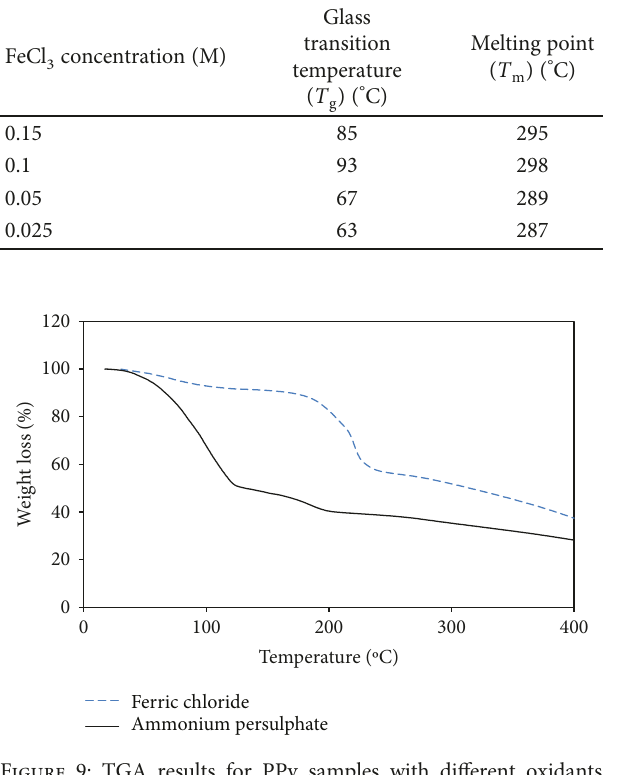
Figure 9: TGA results for PPy samples with di ff erent oxidants (pyrrole 0.05M, oxidant 0.1M, and surfactant 0.025 M, at 25 ° C duration 4h).